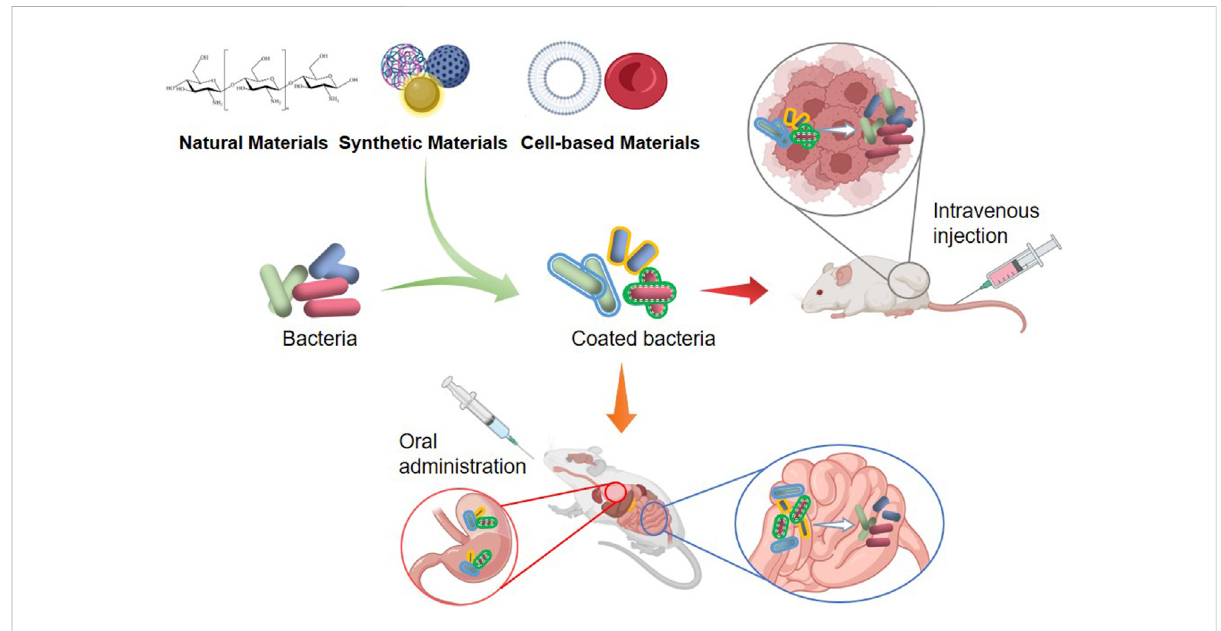
FIGURE 1 Typical materials for the delivery of